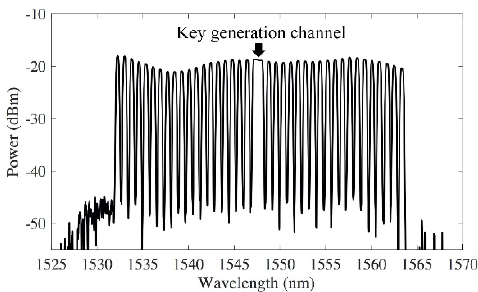
Figure 2. Spectrum of the key generation channel and the dummy WDM channels.